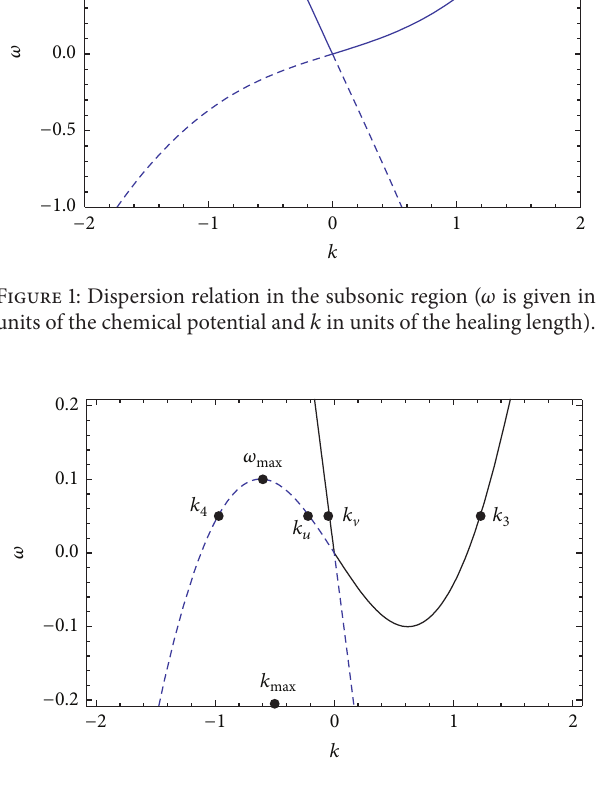
Figure 2: Dispersion relation in the supersonic region (again, 𝜔 is given in units of the chemical potential and 𝑘 in units of the healing